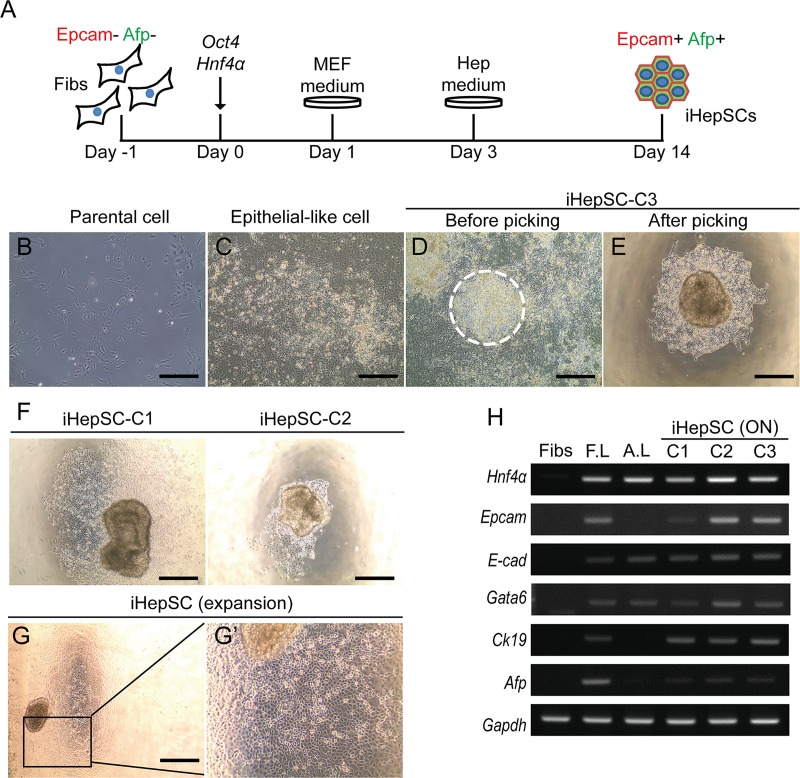
Generation of induced hepatic stem cells (iHepSCs) from fibroblasts by overexpressing of Oct4 and Hnf4α.(A) Direct conversion scheme for iHepSCs. Mouse fibroblasts (Fibs) were infected with lentivirus expressing Oct4 and Hnf4α (2F). The virus contained medium was changed to fresh MEF medium at one day post-infection (dpi). The culture medium was switched to HEP medium (at day 3), and maintained until iHepSC colonies appeared. (B) Image of parental cells before viral infection. (C) Image of typical epithelial cell clusters at 10 dpi. (D) Image of iHepSC colonies at day14. (E) Image of iHepSC-C3 after picking. The white dashed circle in (D) indicates the isolated colony. Scale bars: 250 μm. (F) Images of iHepSC-C1 and iHepSC-C2. Scale bars: 250 μm. (G-G’) Expansion of isolated iHepSC colony. The black box enlarged in (G’). Scale bars: 250 μm. (H) Gene expression analysis of HepSC and hepatocyte- specific markers in fibroblasts (Fibs), three iHepSC clones (C1~3) and liver tissues (E14.5 fetal liver: F.L; adult liver: A.L).